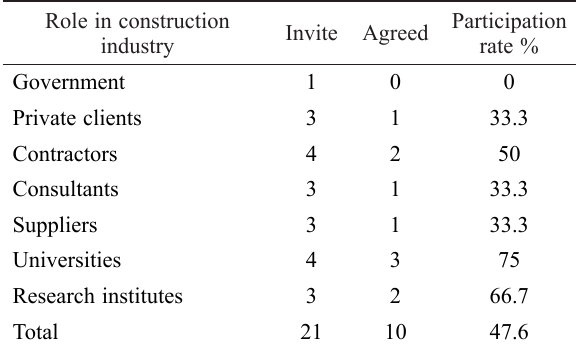
Table 3. Participation rate (in percentage) by type of role in construction industry Role in construction